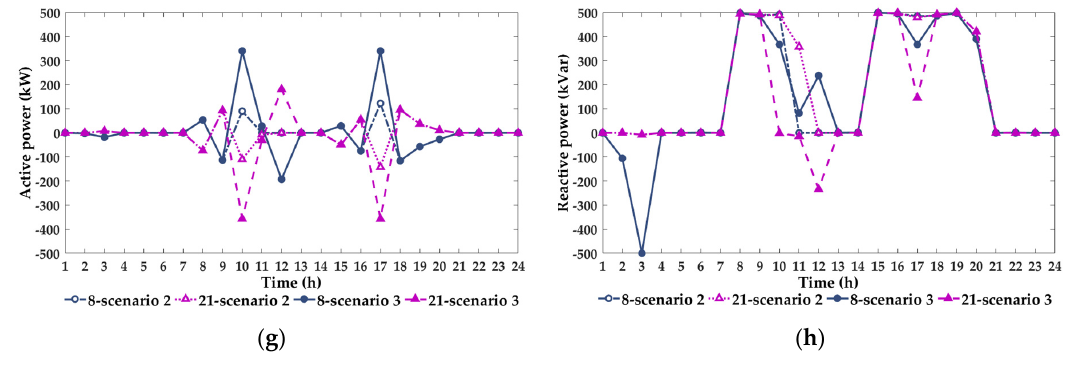
Figure 8. ( a ) Operation strategy of the active power of SOP integrated at nodes 12 and 22. ( b ) Operation strategy of the reactive power of SOP integrated at nodes 12 and 22. ( c ) Operation strategy of the active power of SOP integrated at nodes 25 and 29. ( d ) Operation strategy of the reactive power of SOP integrated at nodes 25 and 29. ( e ) Operation strategy of the active power of SOP integrated at nodes 18 and 33. ( f ) Operation strategy of the reactive power of SOP integrated at nodes 18 and 33. ( g ) Operation strategy of the active power of SOP integrated at nodes 8 and 21. ( h ) Operation strategy of the reactive power of SOP integrated at nodes 8 and 21. Table 3. Performance comparison of the four scenarios.